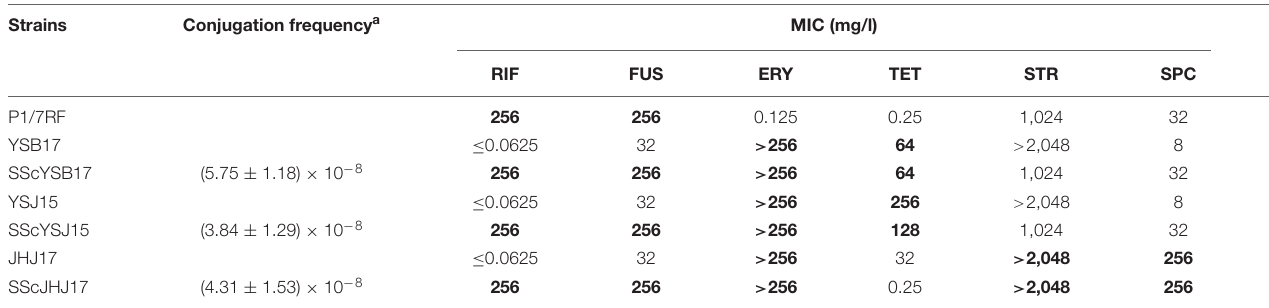
TABLE 1 | Characteristics of strains included in the filter mating conjugation experiments performed in this study.